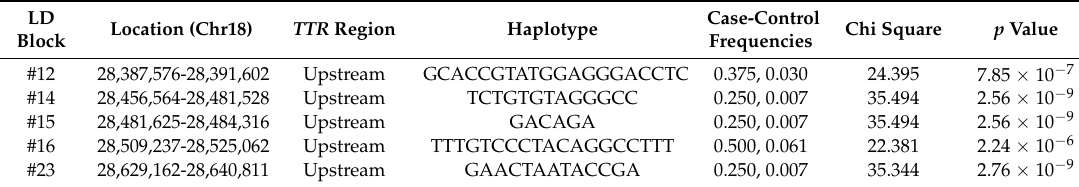
Table 2. Haplotype associations with “having 10 or more outpatient surgeries” that survived multiple testing correction ( p < 8.45 × 10 − 5 ) in the carriers-only sample ( n = 152).